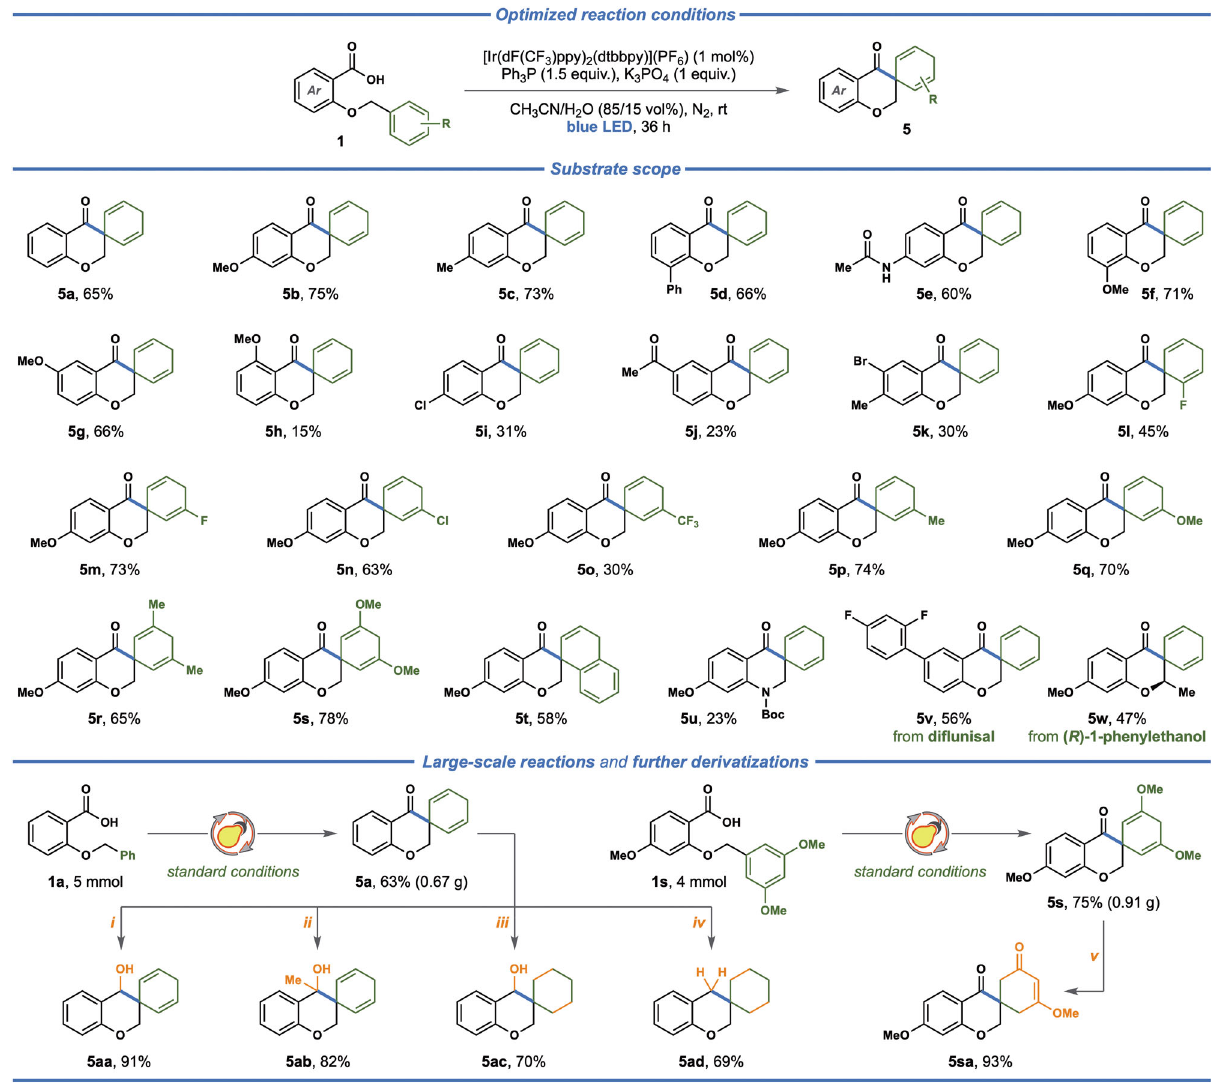
Fig. 3 Scope for the radical-based intramolecular dearomative spirocyclization. Reaction conditions: carboxylic acid (0.3 mmol, 1 equiv.), triphenylphosphine (1.5 equiv.), K 3 PO 4 (1 equiv.), [Ir(dF(CF 3 )ppy) 2 (dtbbpy)](PF 6 ), (1 mol%) CH 3 CN/H 2 O (85:15 vol%, 6 mL), N 2 , blue LEDs (440 nm), 36 h, fan cooling (35 – 40 °C). Further derivatization of products 5a and 5s were performed under the following conditions: (i) NaBH 4 , MeOH, 0 °C, 2 h; (ii) MeMgBr, THF, 0 °C, 16 h; (iii) H 2 , Pd/C, MeOH, 12 h; (iv) H 2 , Pd/C, MeOH, 60 h; (v) TFA, CH 2 Cl 2 , 16